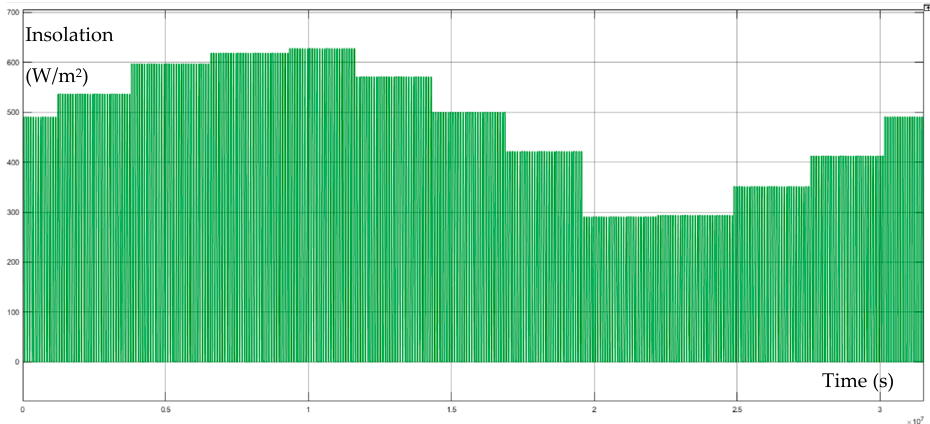
Figure 2. Insolation (W/m 2 ) in Manipal city, India during the year 2020, starting from April.